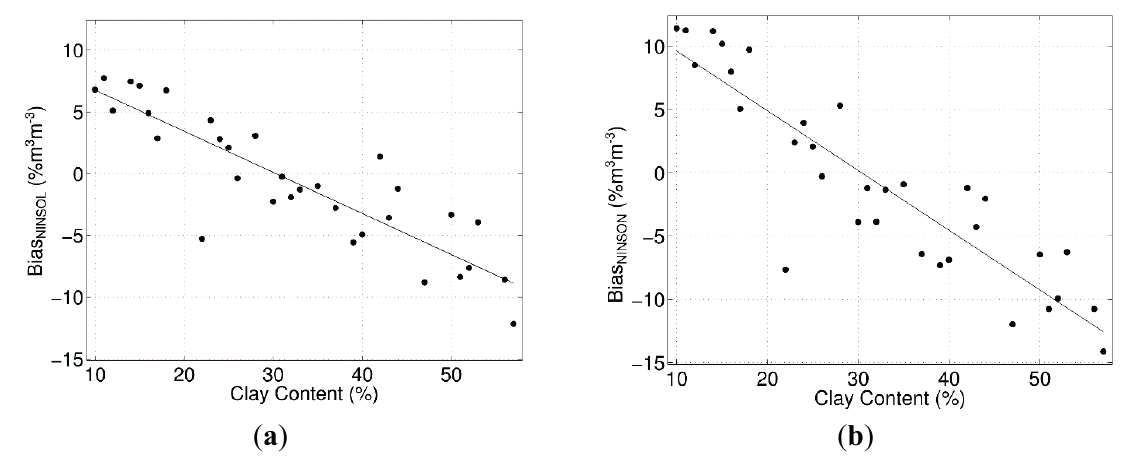
Figure 9. Relationships estimated between soil moisture content bias (Equation (8)) for each value of clay content, versus the clay content (see Equations (12) and (13)). For ( a ) NINSOL case and for ( b ) NINSON case.